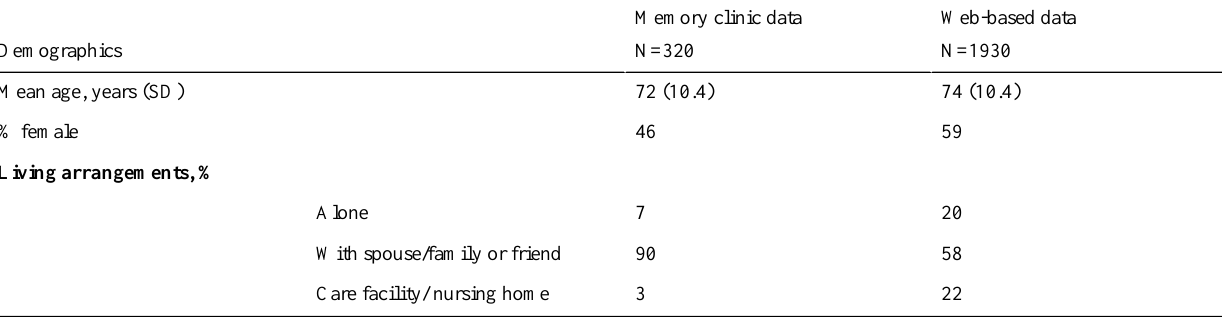
Table 1. Demographic characteristics of Memory Clinic patients and Web users.